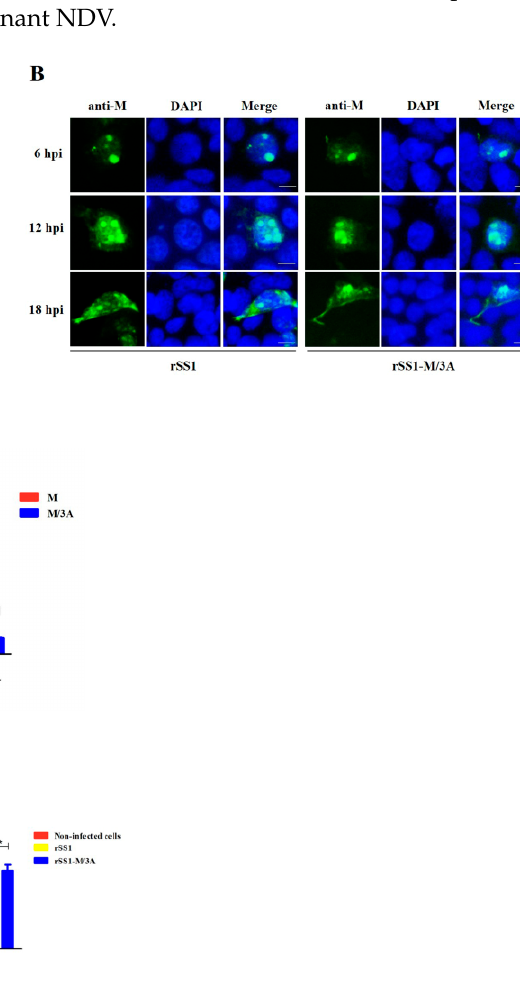
Figure 4. The M/3A protein causes the reduced viral RNA synthesis and transcription of recombi- nant NDV. ( A ) Viral RNA synthesis and transcription ( B ) corresponding to the NP and P genes in virus-infected cells were detected by qRT-PCR at different time points. ( C ) The expression of viral NP and HN proteins was detected by Western blotting. Asterisks denote significant differences (*, p < 0.05; **, p < 0.01).